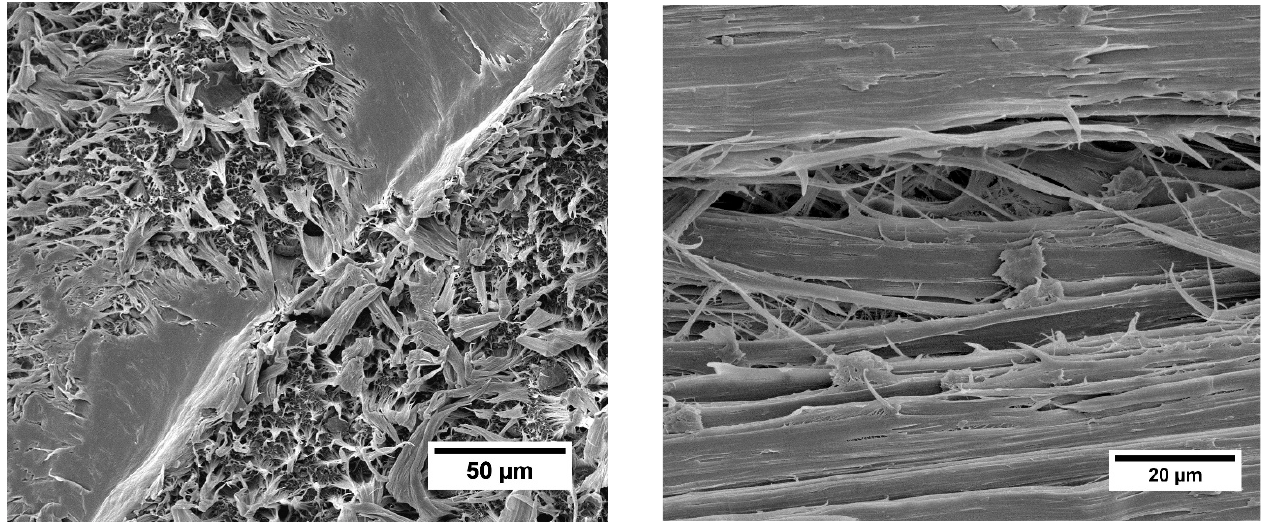
Figure 7. SEM images of a broken mechanical test specimen composed with CNF-PSA/HDPE at fracture point .